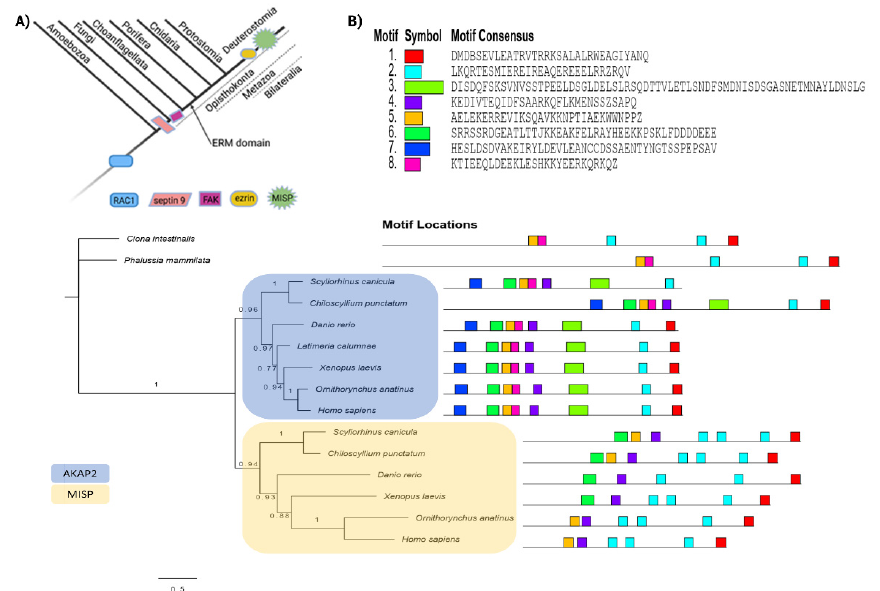
Figure 5. Analysis of evolutionary origins of crosstalk proteins found at intersection of 3 cytoskeletal protein datasets. ( A ) Evolutional emergence of crosstalk proteins found in 3 datasets starting with RAC1 (blue), followed by septin 9 (red), FAK (purple), ezrin (yellow) and MISP (green) as the newest cytoskeletal crosstalk player detected in this analysis. Although ezrin is evolutionary young protein, ERM domain is present before Metazoa. ( B ) Identification of conserved repeated motifs was obtained by MEME suite; motif consensuses are designated in upper right box. Phylogenetic and conserved domains analysis of MISP and its homologs in different Chordata species (lower box). ML tree of MISP homologs, aLRT values are used to infer branch support, values on the main branches are indicated. Phallusia mammilata and Ciona intestinalis (Chordata, Tunicata) homologs are placed as outgroup. Sequences IDs are listed in Supplementary Table S1 (Sheet 7).